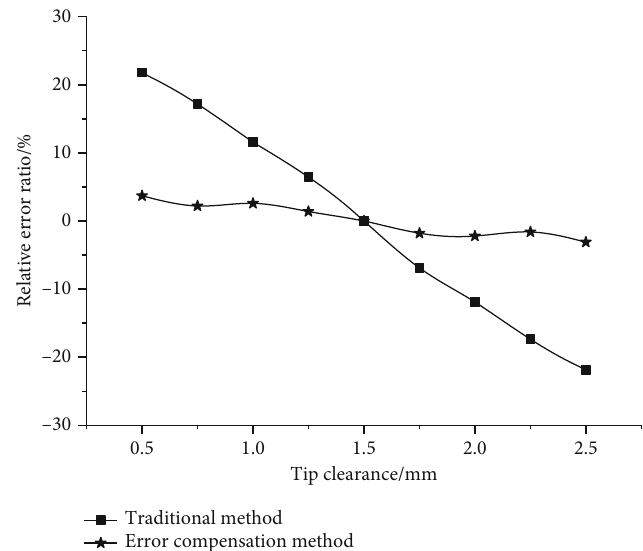
Figure 8: Comparison of the traditional and error compensation method.